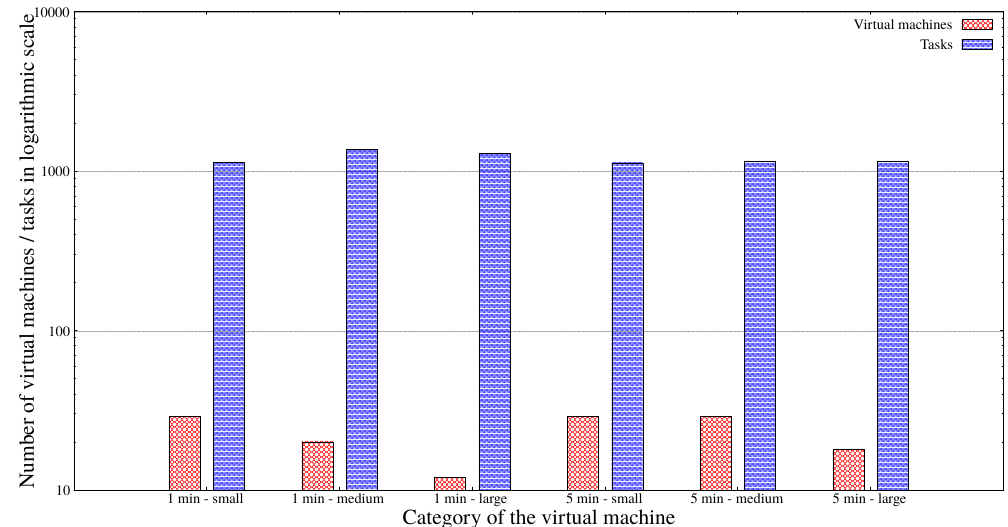
Figure 16. Cost of the Oracle cloud provider in scenario N o 4.